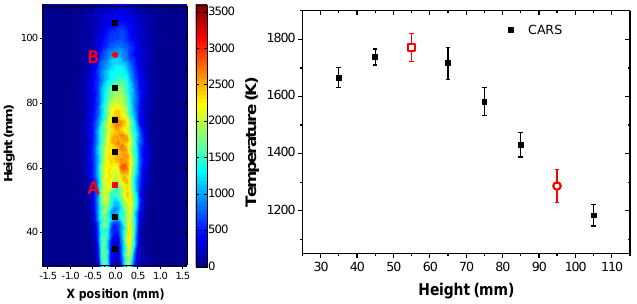
Figure 4. Fluorescence image of OH and the measured temperature from CARS.